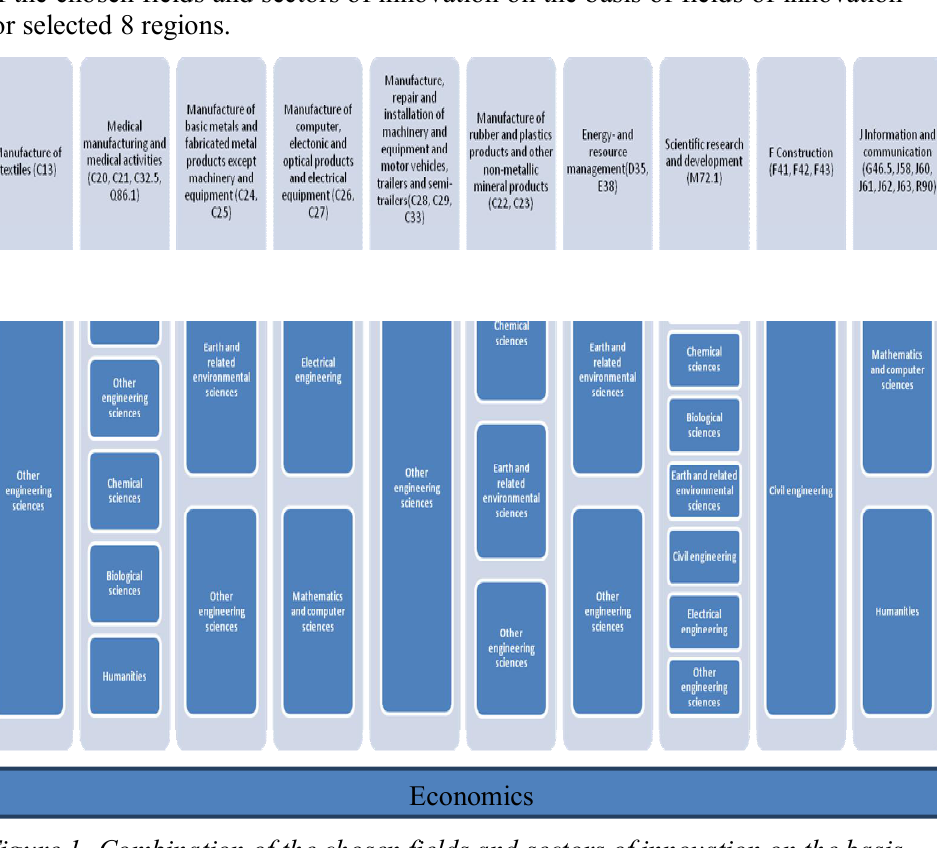
Figure 1- Combination of the chosen fields and sectors of innovation on the basis of fields of innovation (Faber, Ch. ,